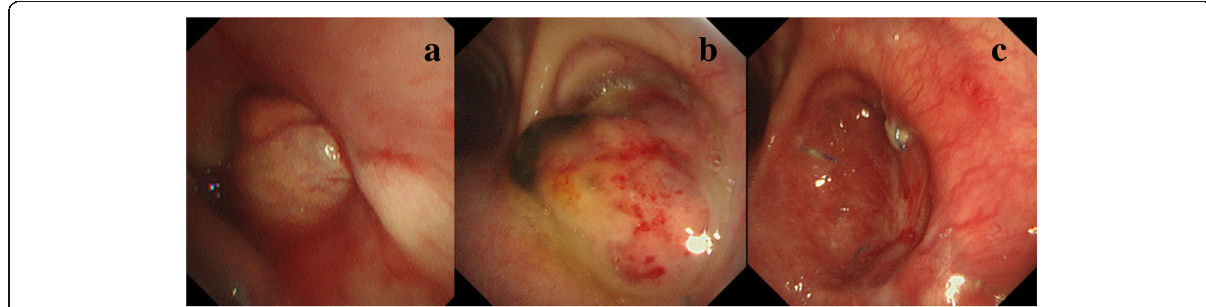
( a ). Postoperative day 7 ( b ). At 4 months after the omentopexy ( c